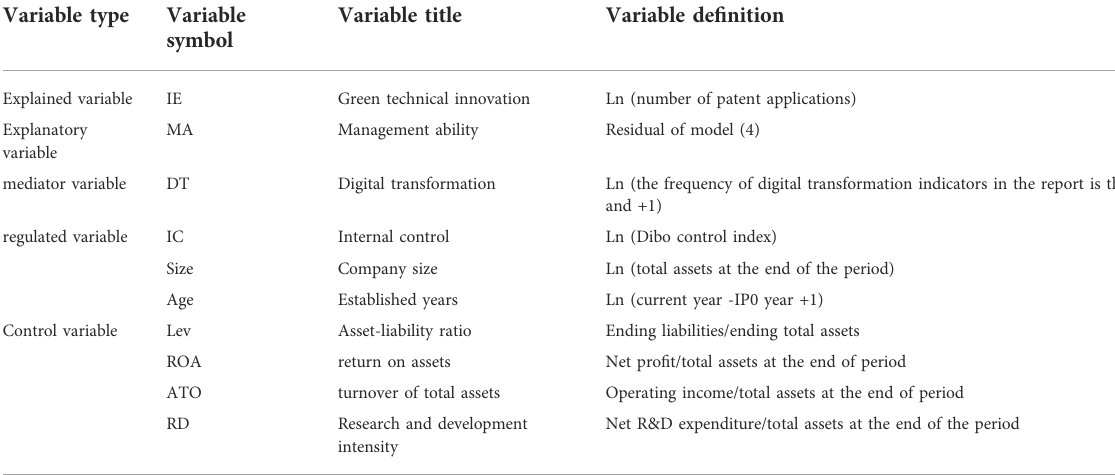
TABLE 1 De fi nition of main